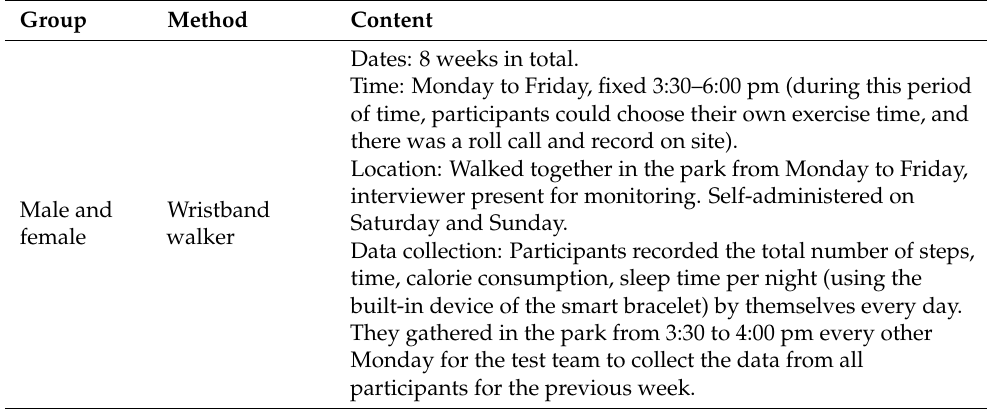
Table 1. Experimental method and content.